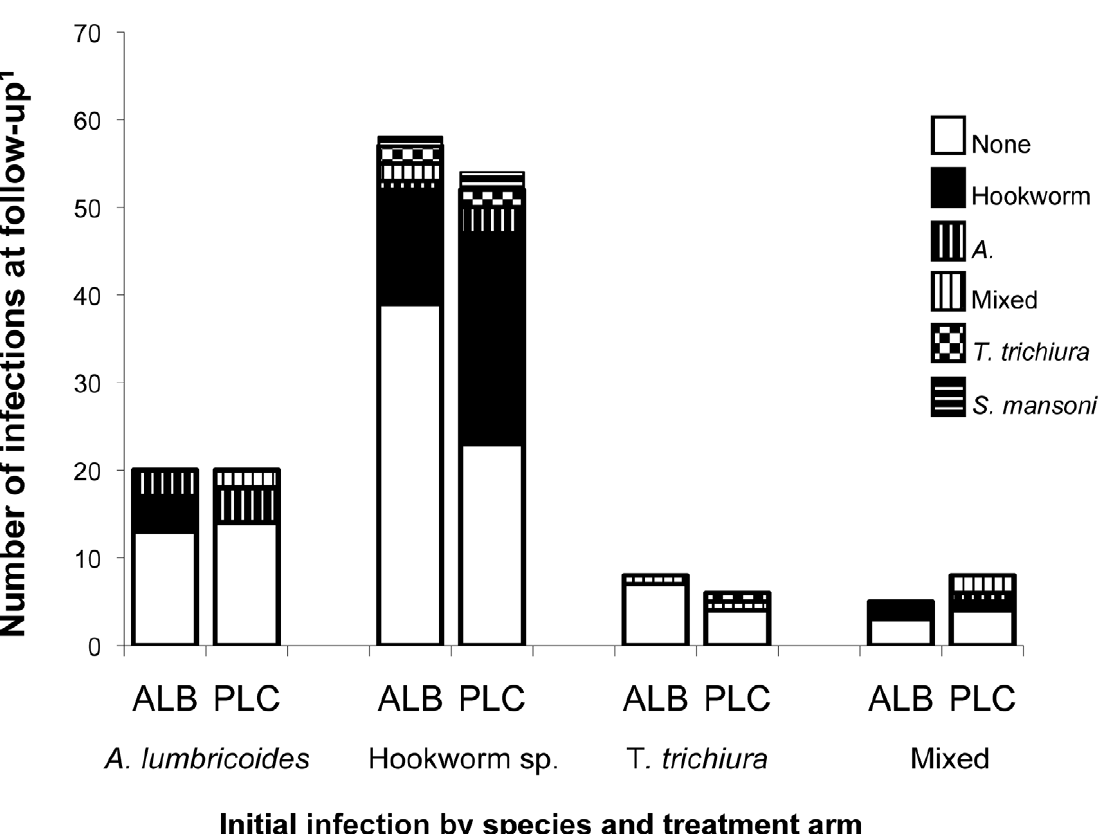
Figure 4. Species-specific helminth infection twelve weeks after albendazole or placebo treatment. 1 Total number of individuals with follow-up stool available, stratified by species of initial infection and treatment arm. ALB, albendazole; PLC,